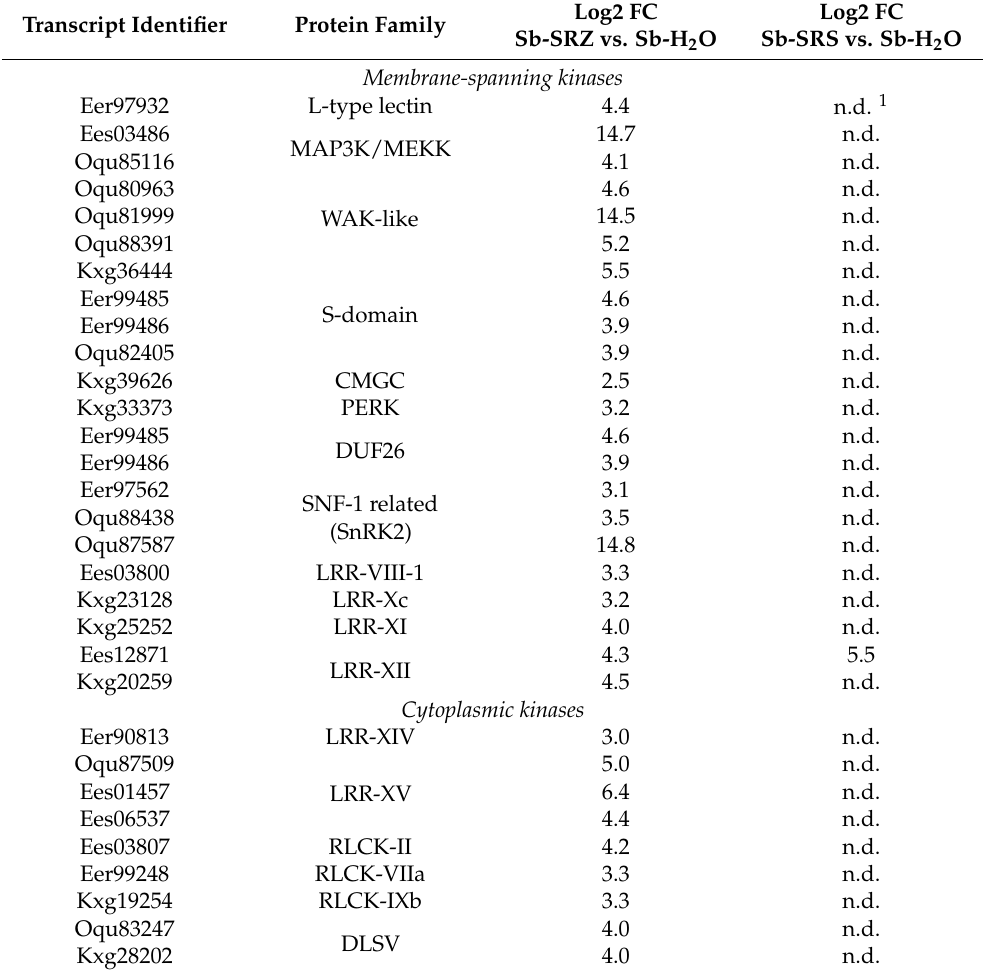
Table 3. Sorghum kinases upregulated in the comparison of Sb-SRZ vs. Sb-H 2 O or Sb-SRS vs. Sb-H 2